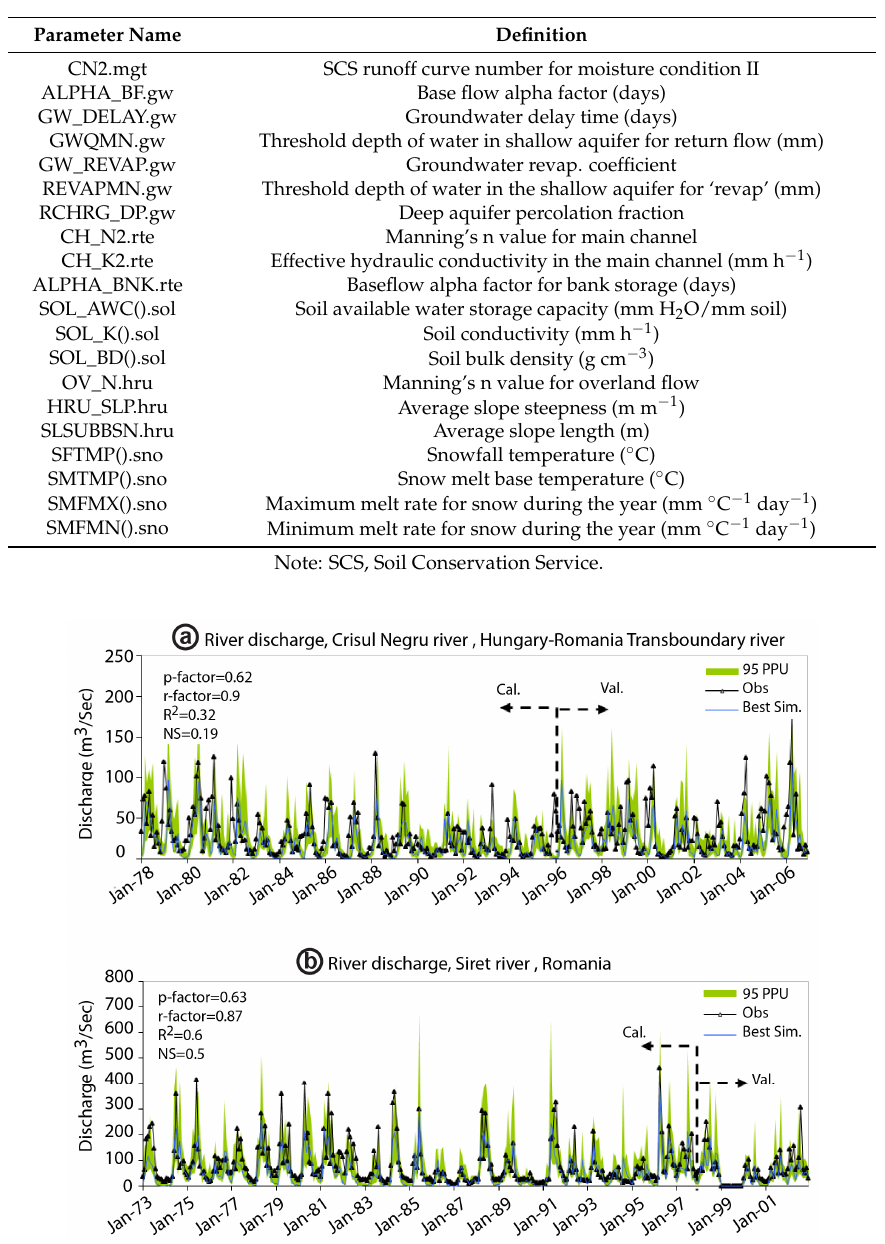
Table 4. List of sensitive parameters used for model calibration.